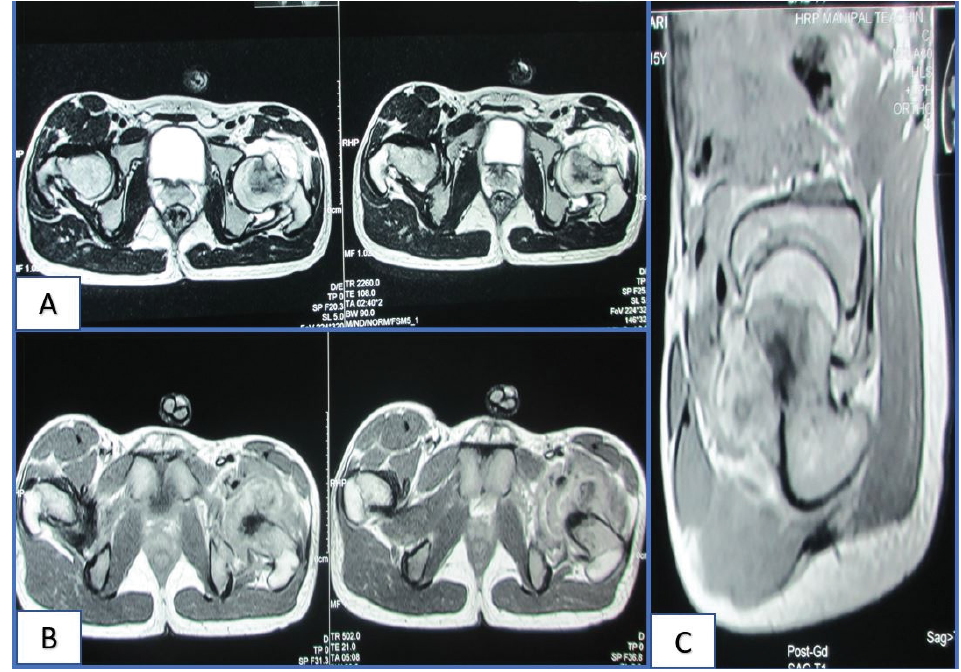
Figure 2: MRI T2W images show heterogeneous signal intensity lesion with areas of sclerosis involving the femoral head and neck. The large associated soft tissue in the anterior aspect appears predominantly hyperintense on T2W images (A). Post- contrast axial (B) and sagittal (C) images show heterogeneous enhancement with areas of necrosis involving soft